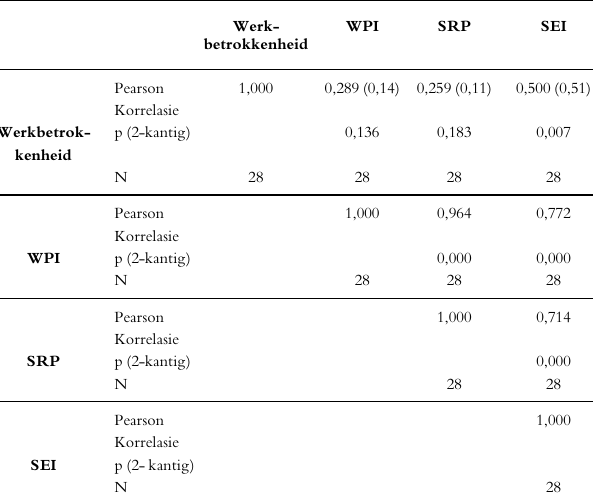
Tabel 7 dui daarop dat werkbetrokkenheidtellings onderling statisties-beduidend met dieWPI, SRPen SEI korreleer. Hier- die korrelasies se e¡ekgroottes is almal statisties, hoogs bedui- dend. Dit blykook dat dieWPI betekenisvol korreleer met die SRP en SEI. Die SRP korreleer weer op sy beurt, stastisties- beduidend met die SEI. UitTabel 8 is dit duidelikdat daar’n statisties-beduidende korre- lasie tussen die tellings van dieWPI en die SRP, dieWPI en